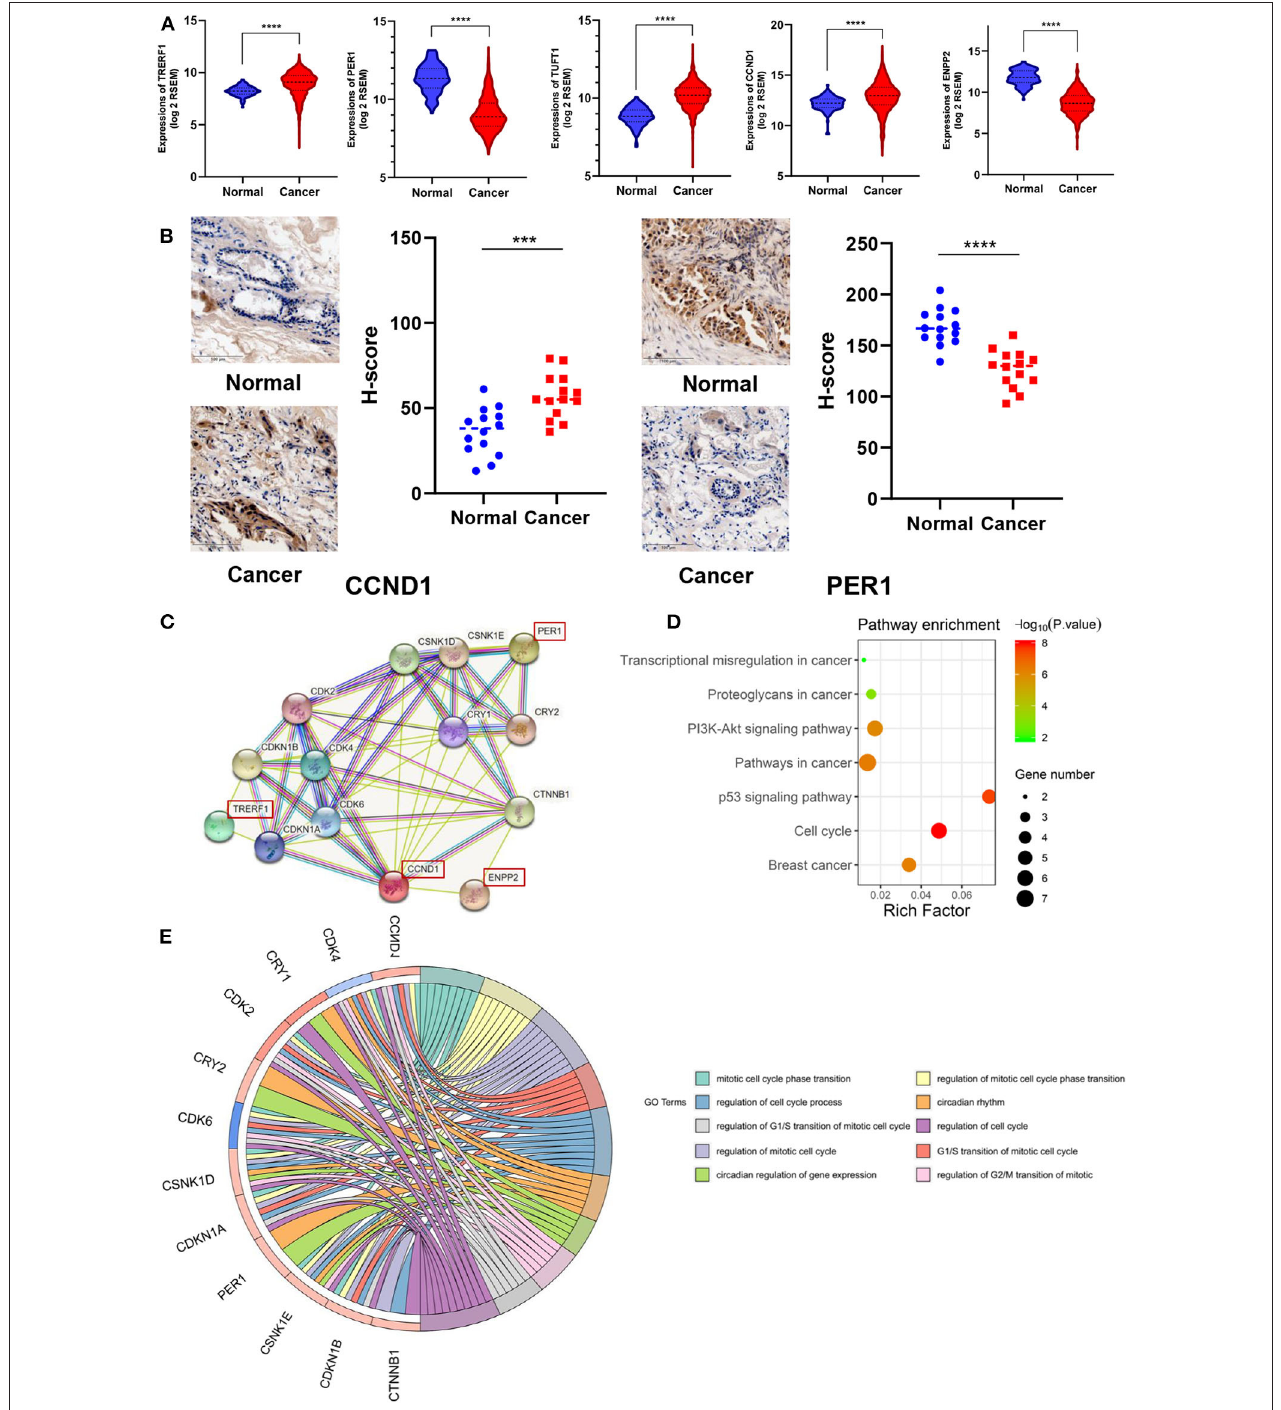
FIGURE 3 | Association of 7 DNA methylation signatures with the cell cycle. (A) DMSs corresponding genes expression in TCGA. (B) CCND1 and PER1 protein expression in 14 paired BRCA and adjacent tissue by IHC assay. (C) PPI expression network for six genes corresponding to the seven methylation sites. (D) The KEGG pathway analysis of the mRNA of the PPI network map of the seven methylation sites corresponding gene. The vertical axis is the enriched pathway, and the horizontal axis is the number of genes enriched in this pathway compared to the number of genes on this pathway. (E) GO enrichment analysis. The circle indicates the correlation between the methylation-driven mRNAs and their gene ontology